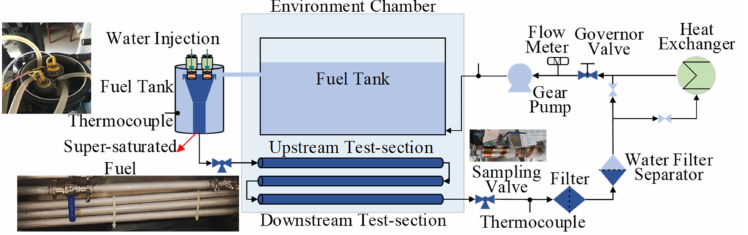
Figure 1. Schematic representation of the icing test rig. (Dark blue indicates supersaturated fuel, and light blue indicates saturated